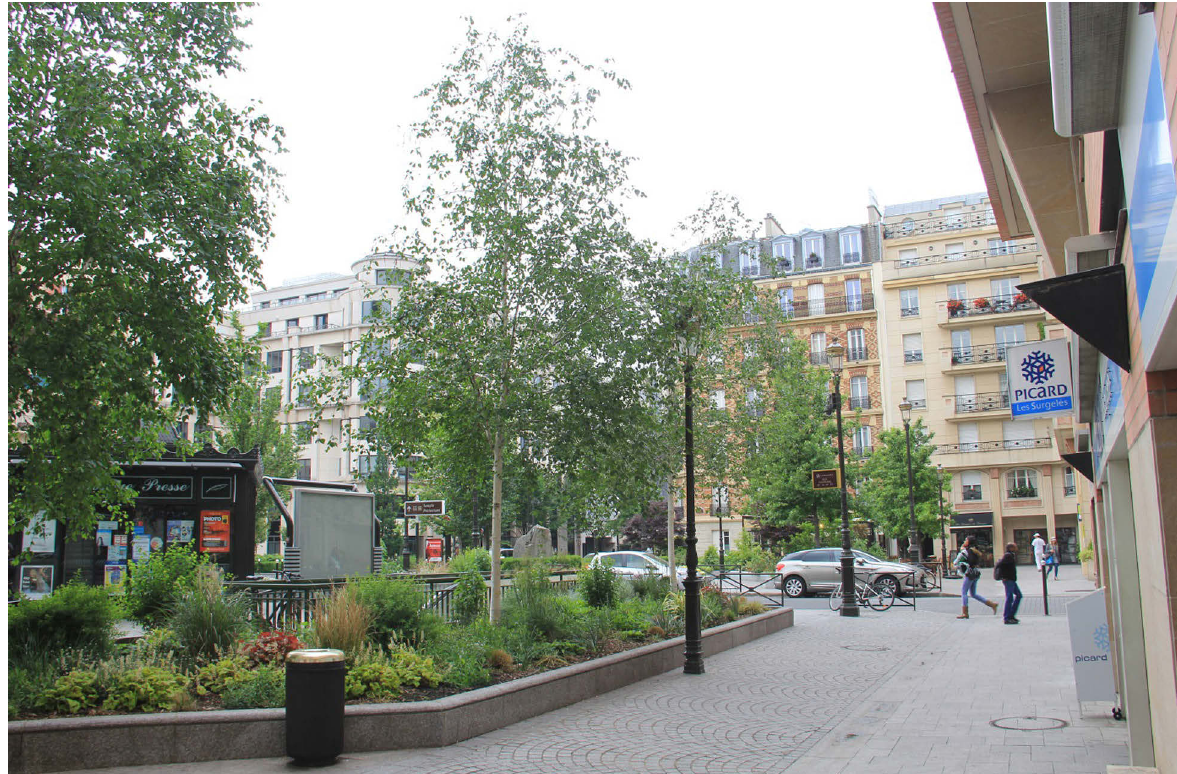
Fig. 4. Life as an orderly idyll: Levallois-Perret (photo: Florian Weber